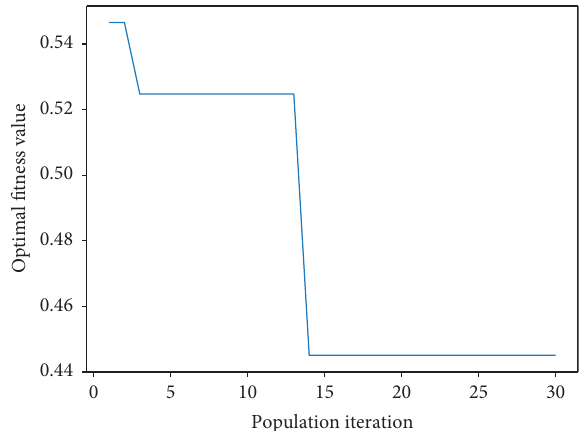
Figure 5: The trend graph of fitness value